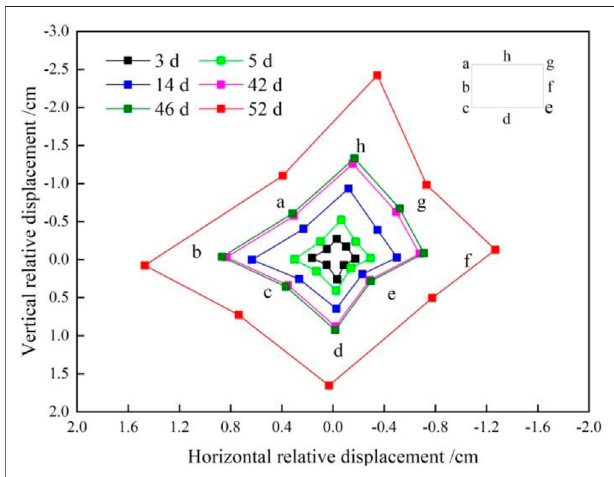
FIGURE 12 | Relative displacement of a roadway section at different times in the damp